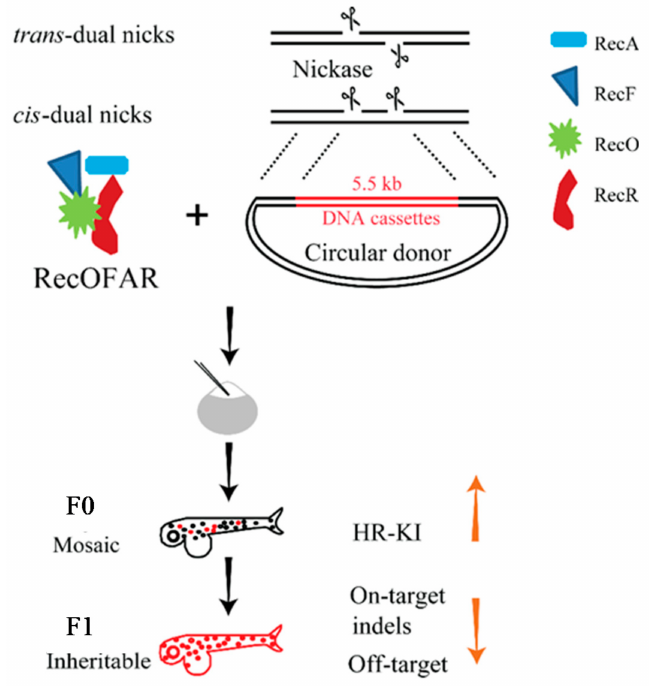
Figure 3. Nickase-based homologous recombination enhanced by recOfar factors (NEO) mediated gene editing in zebrafish. The genome editing strategy is called nickase-based homologous recom- bination enhanced by recofar factors (NEO). The bacterial RecA protein together with RecO, RecR, and RecF factors can enhance accurate HR-KI induced by trans -dual nicks (two cooperative nicks induced on the complementary strands) or cis -dual nicks (both nicks on a same strand) in zebrafish. Furthermore, the NEO system can enable KI of >5.5-kb-long DNA cassettes into the zebrafish genome. In addition, both on-target and off-target indels that are prevalent when conventional Cas9 strategies are adopted could be substantially reduced via NEO in zebrafish. The upward yellow arrow indicates an increase in HR-KI efficiency. The downward yellow arrow indicates a decrease in the on-target and off-target indel count